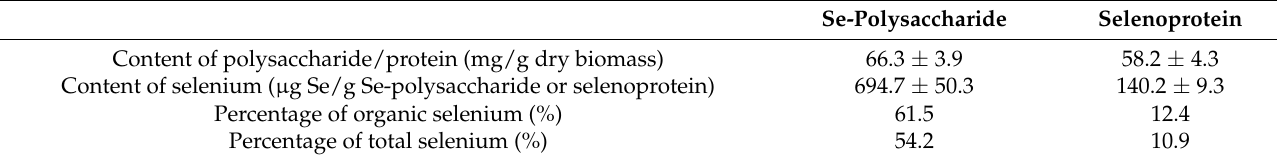
Table 3. Composition of organic selenium.